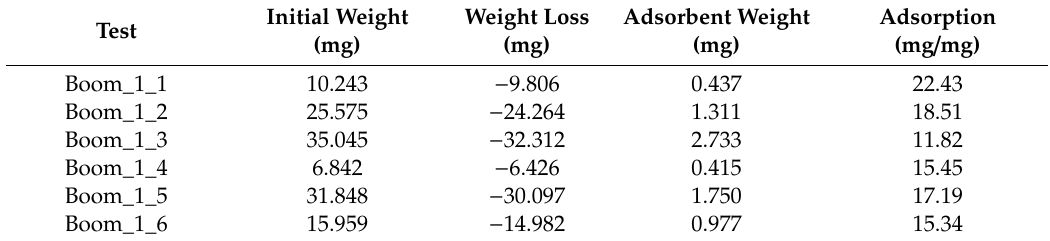
Table 3. TGA tests on Grafysorber ® samples from Nigeria.